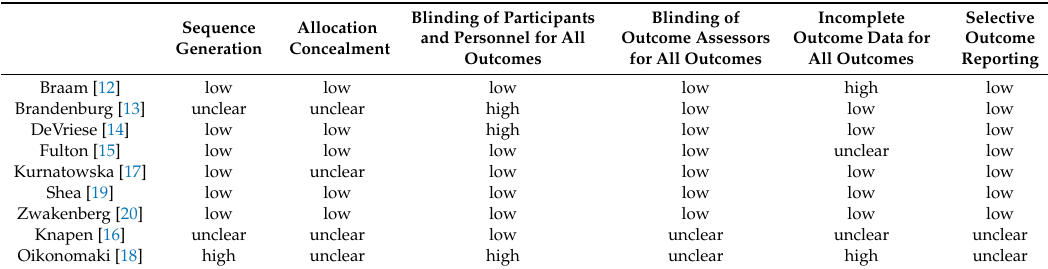
Table 3. Study quality